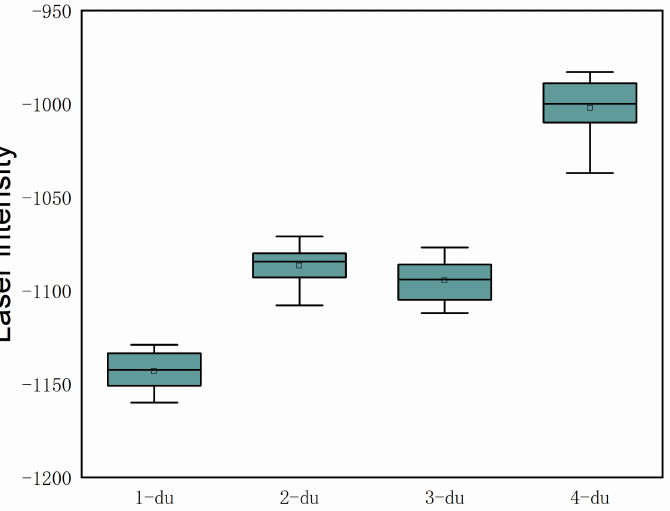
Figure 7. Boxplot of laser intensity values of bamboo culms of different bamboo du. The central lines within each box are the medians. The boxes’ edges represent the upper and lower